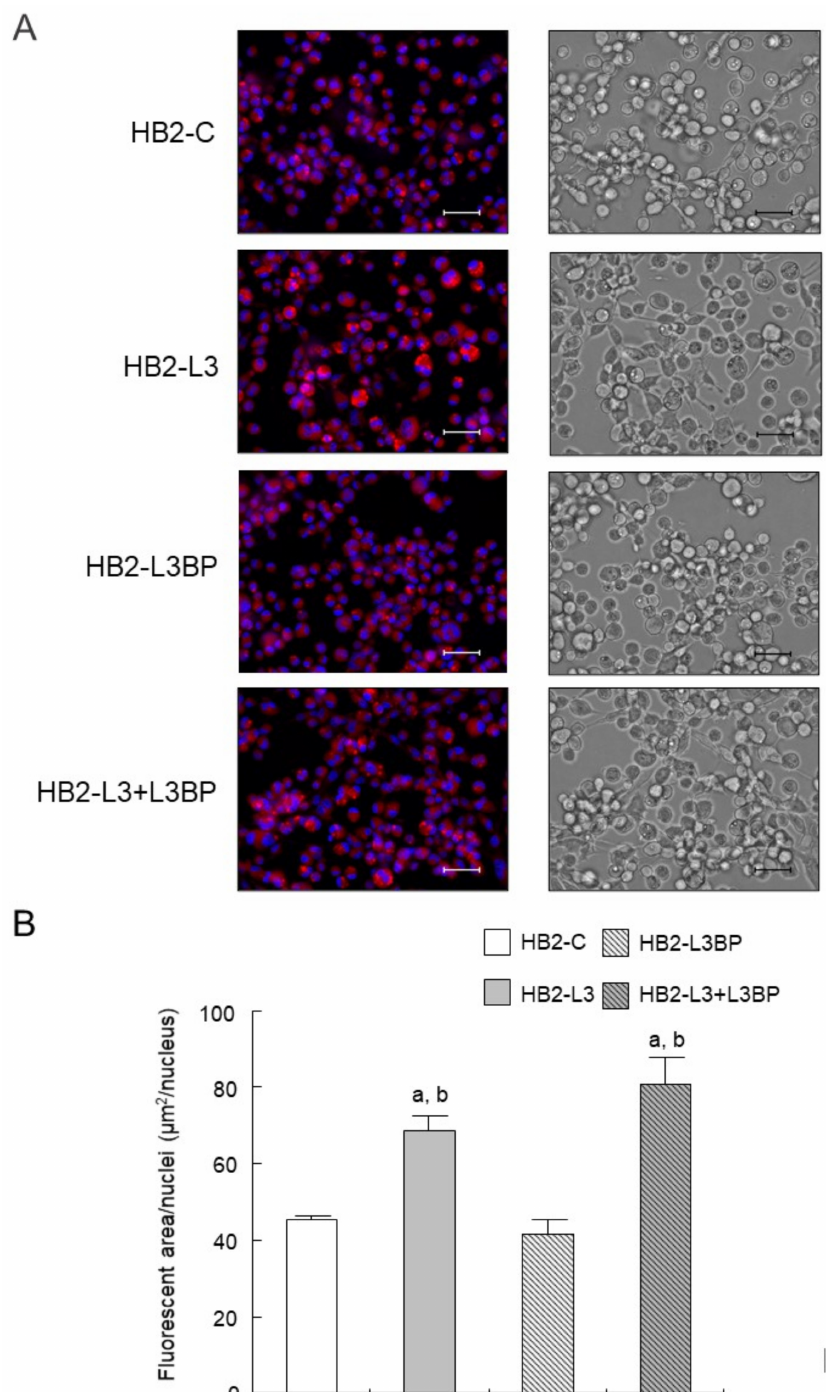
Figure 2. Effects of Lgals3 and Lgals3bp on lipogenesis in HB2 cells. ( A ) Lipid droplets in HB2 transfectants after mature differentiation were stained red using a Nile red solution. Representative photomicrographs (left) and corresponding bright field images (right) are shown. Each scale bar indicates 50 µ m. ( B ) Measured areas of staining with Nile red per the number of Hoechst positive nuclei are calculated in three different fields of view. The mean ± SE values ( n = 3) are given: a p < 0.05 vs. HB2-C cells; and b p < 0.05 vs. HB2-L3bp